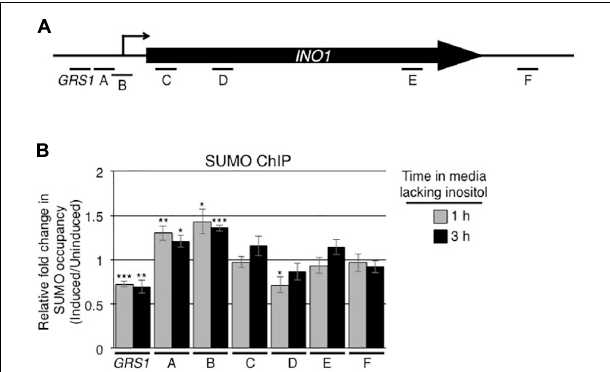
FIGURE 1 | Induction of INO1 leads to changes in the sumoylation of INO1 -associated proteins. (A) Diagram of the INO1 locus showing the relative positions of the transcriptional start site (arrow), the GRS1 sequence, the open reading frame, and regions targeted for the ChIP analysis shown in B . (B) WT cells were grown in medium containing inositol (repressing/uninduced conditions) to an OD 600 of ∼ 0.8, washed, and transferred to medium lacking inositol (inducing conditions). Cells were then subjected to ChIP analysis using antibodies directed against the SUMO polypeptide (anti-SUMO antibody) prior to and at 1 and 3 h post induction of INO1 . qRT-PCR was used to quantify levels of DNA corresponding to the various regions of INO1 (see A ) bound to sumoylated proteins. Shown is the relative fold change in the occupancy of sumoylated proteins associated with the various regions of INO1 at the indicated times after induction relative to the uninduced samples (see section “Materials and Methods”). Results are the means ± SEM of five biological replicates. Asterisks indicate a significant difference relative to uninduced as determined by a Student’s paired t -test. * p < 0.05, ** p < 0.01, *** p < 0.001.